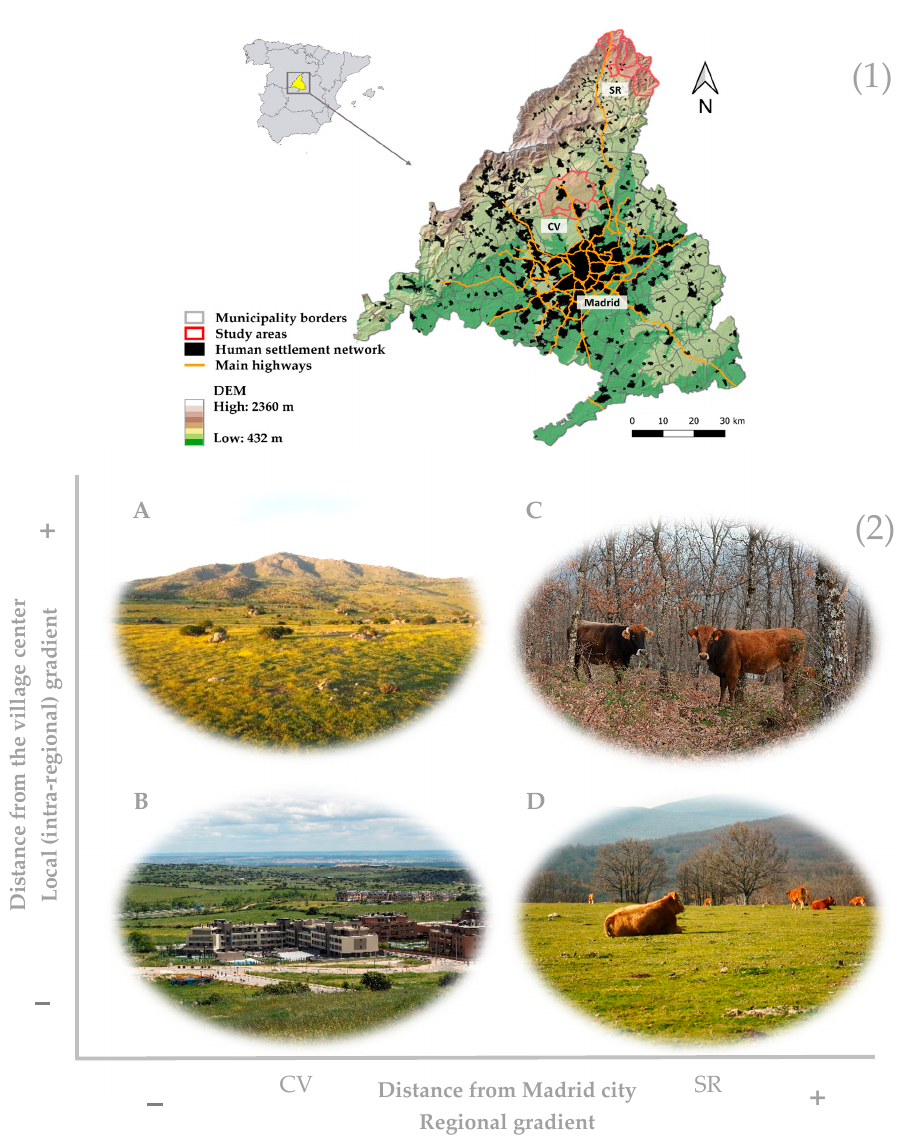
Figure 1. ( 1 ) Location of the study areas in Madrid region, Spain; ( 2 ) Pictures of the study areas within a double gradient: regional urban-rural gradient determined by Madrid city (X-axis), and a local gradient of close to/far from the village center (Y-axis). DEM: Digital Elevation Model; CV: municipalities of Colmenar Viejo and Tres Cantos (photos A , B ); SR: municipalities included in Sierra del Rincón (photos C , D ).